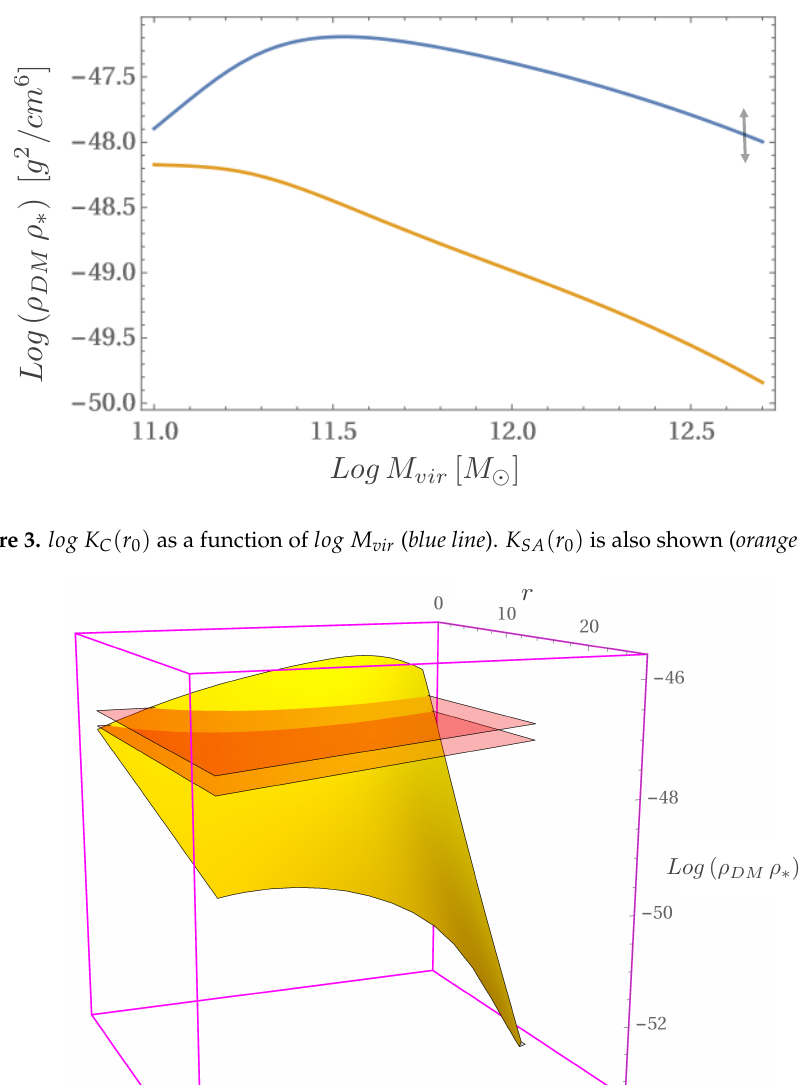
and r / kpc ( yellow surface ). In Spirals, the full (cid:12)